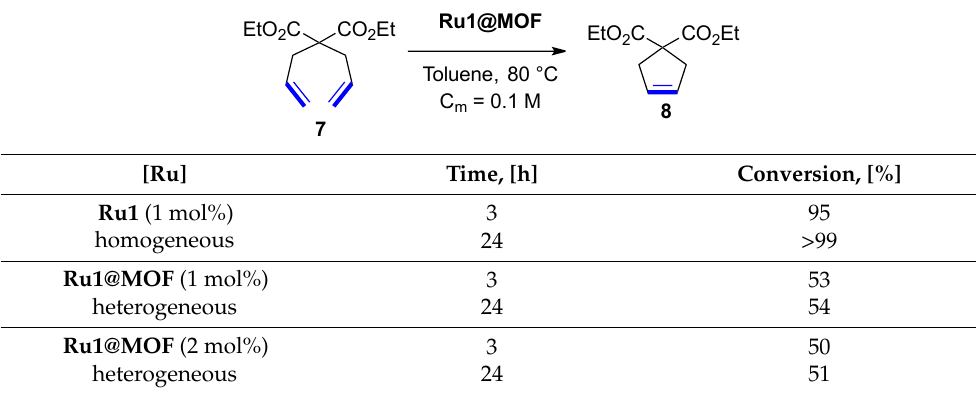
Table 2. Results of the RCM reaction of DEDAM ( 7 ) with Ru1 and Ru1@(Al)MIL-101-NH 2 com- plexes in toluene. (C [ 7 ] = 0.1 M). Conversion was determined through GC (tetradecane was used as an internal standard).